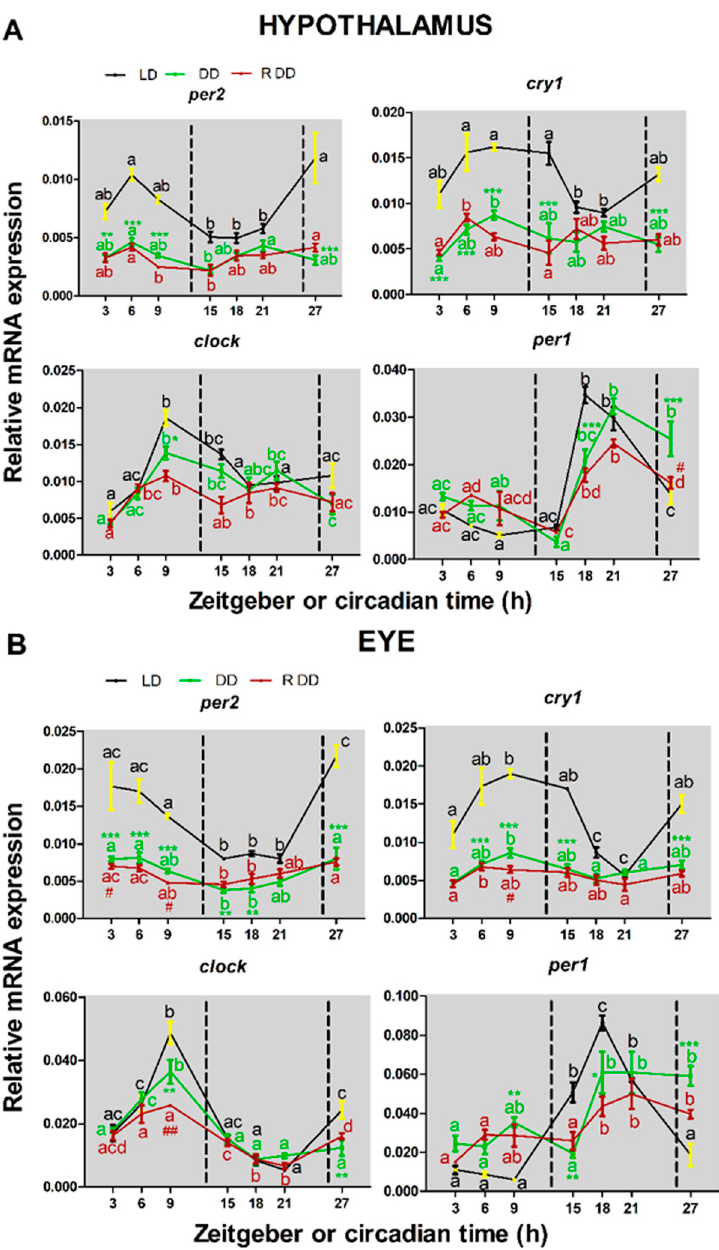
Fig 1. Daily expression of clock genes in central tissues from turbot. mRNA relative expression profiles of per2, cry1, clock and per1 in hypothalamus (A) and eye (B) of fish acclimatized to LD and regular feeding time at ZT2 (LD, black line), 24h in DD and regular feeding time at CT2 (DD, green line) and 24h DD and random feeding time during the light phase (R DD, red line) measured by qPCR. Data represent mean ± SEM of three (eye) or five animals per time point. The dotted black lines delimit the duration of the night in LD conditions or the duration of the subjective night in DD. Different letters of the same colour indicate statistical difference inside a group (p < 0.05 One-way ANOVA followed by Tukey’s test). Asterisks indicate a statistical difference from LD conditions ( � p < 0.05, �� p < 0.01, ��� p < 0.001 Two-way ANOVA followed by Bonferroni’s test). Hash indicates statistical difference from regular feeding time (#p < 0.05, ##p < 0.01, ###p < 0.001 Two-way ANOVA followed by Bonferroni’s test). These time points correspond to ZT 3, 6, 9, 15, 18, 21, 27h. ZT0 represents lights on and ZT12, lights off.